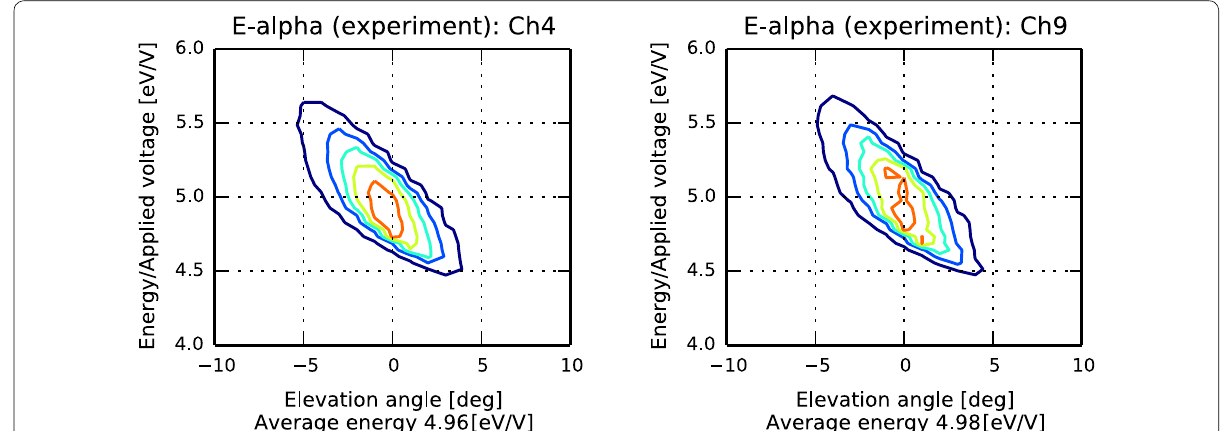
Fig. 8 Energy-elevation angle response of LEPi obtained in laboratory experiments. Responses of azimuthal channel 4 (wide channel) and 9 (nar- row channel) for proton beams with the energy of 12 keV are shown. Contour lines correspond to 5 (blue), 25 (light-blue), 45 (cyan), 65 (yellow), and 85% (orange) of the maximum sensitivity level. Negative voltage is applied to the inner dome of the analyzer to measure the positively charged ions, although the energy per applied voltage in the figure is expressed as positive